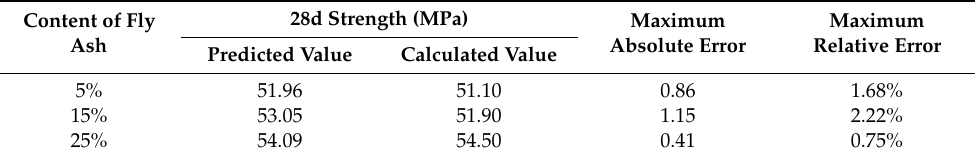
Figure 5. Structural diagram of the BP neural network. Table 8. Forecast results.